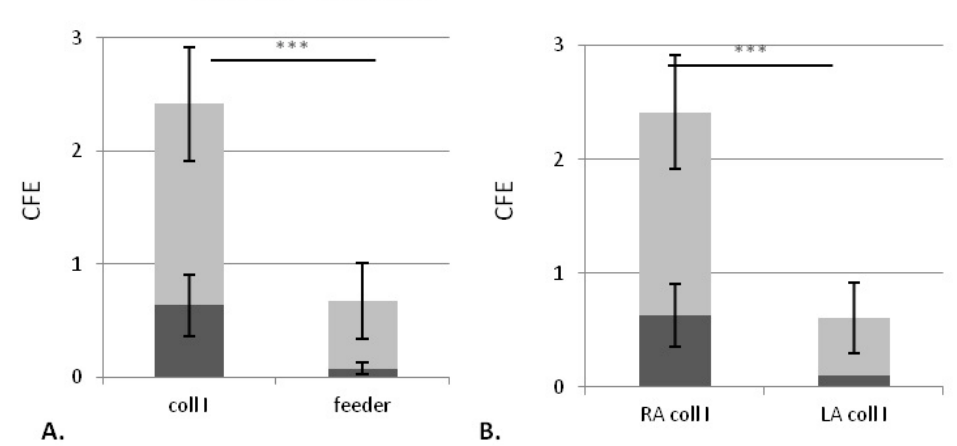
Figure 3. Influence of adhesion support on clonogenic potential of obtained cellular suspension (RA and LA) obtained from model 1 assay. ( A ) CFE obtained for RA after adhesion for 10 min on collagen I or on feeder layers; ( B ) CFE obtained for RA and LA cells after adhesion for 10 min on collagen I. Mean of three donors. n = 3. *** data significantly different p < 0.0005.